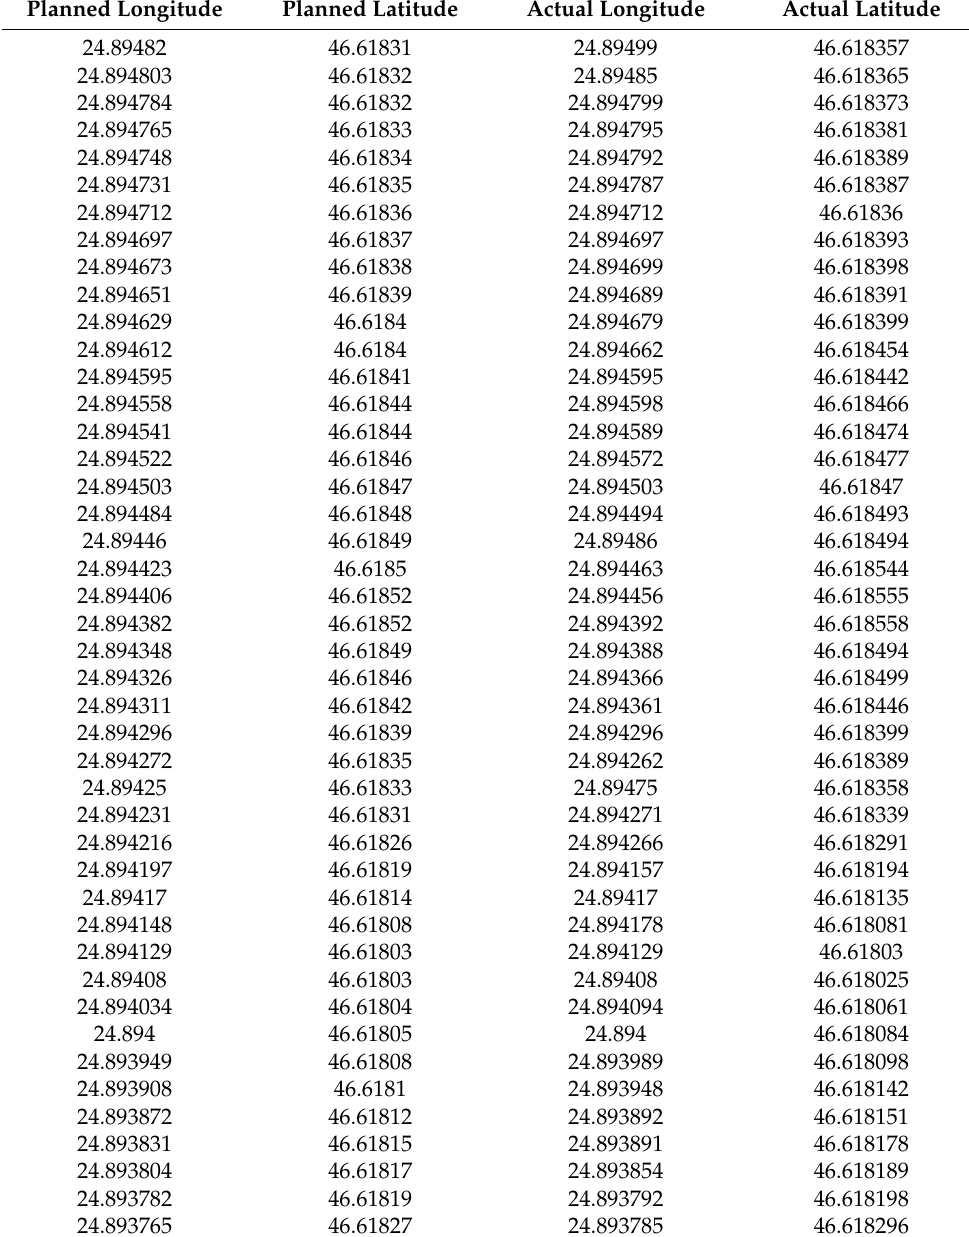
Table 5. Example for one student participant and one